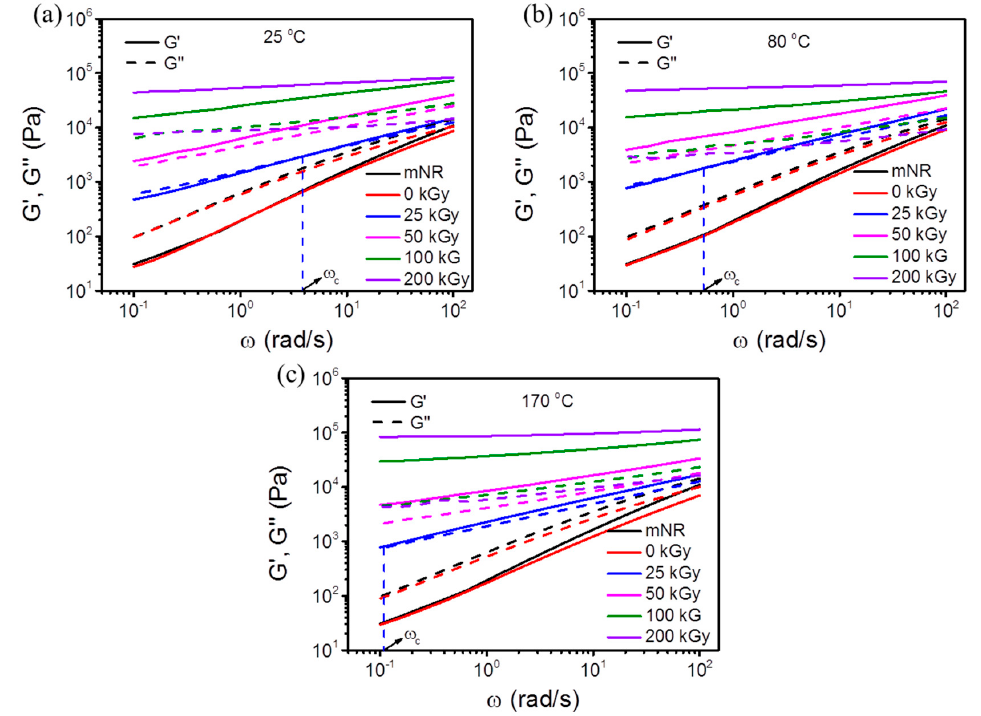
Figure 7. Storage modulus (a, b, c, solid line) and loss modulus (a, b, c, dashed line) as a function of angular frequency for mNR irradiated at 25 °C ( a ), 80 °C ( b ), and 170 °C ( c ) with the dose ranging from 0 to 200 kGy .